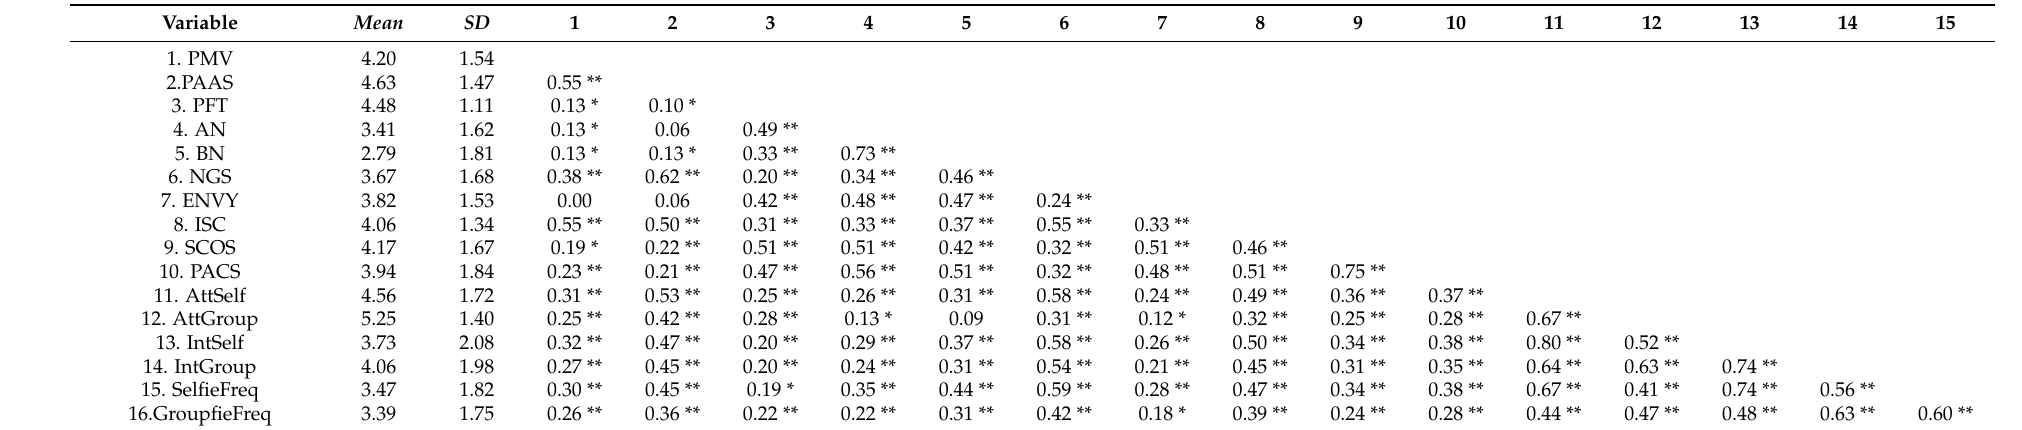
Table 6. Study 3: Means, standard deviations (SDs), and correlations (Pearson’s parametric correlation) of variables ( N = 557). Variable